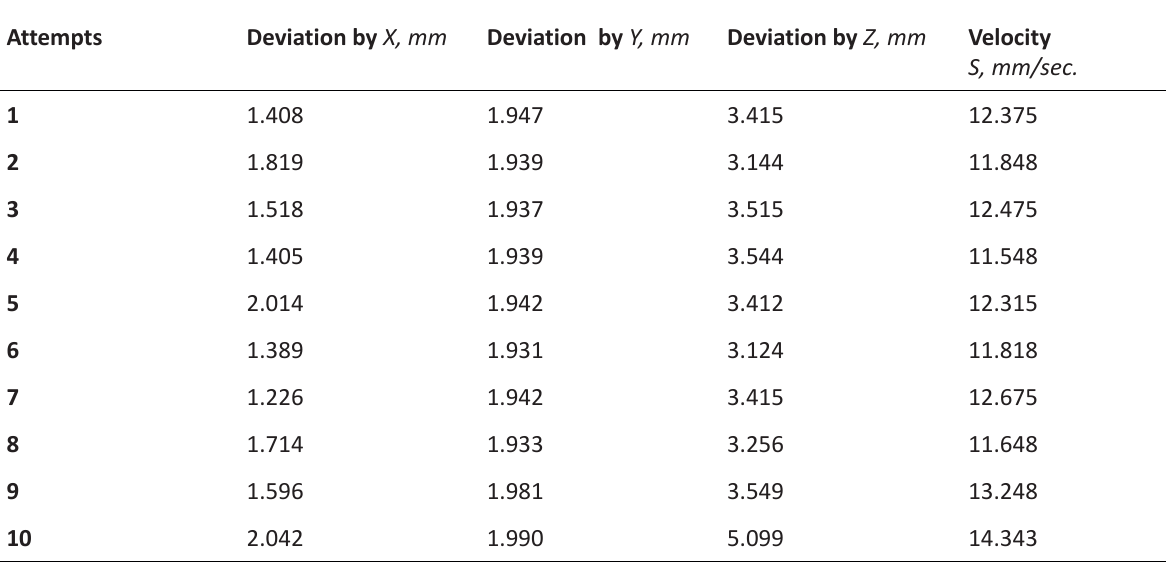
Table 1. Athlete hand’s micro movements in the process of СЕА16 testing, p<0.05 THE MEASURED PARAMETERS